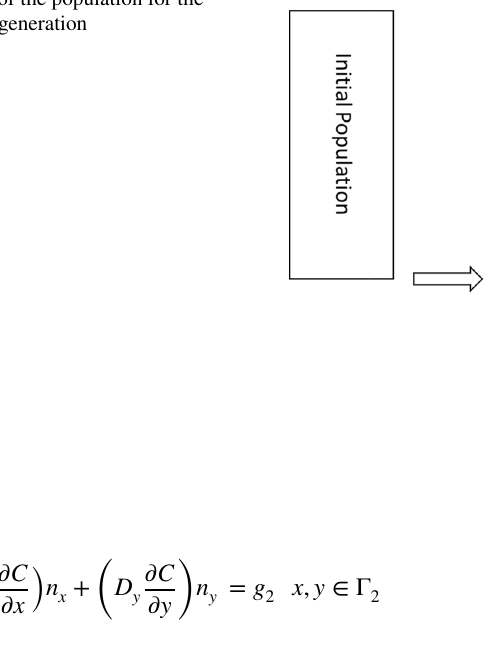
Fig. 4 Choosing the best mem- bers of the population for the next